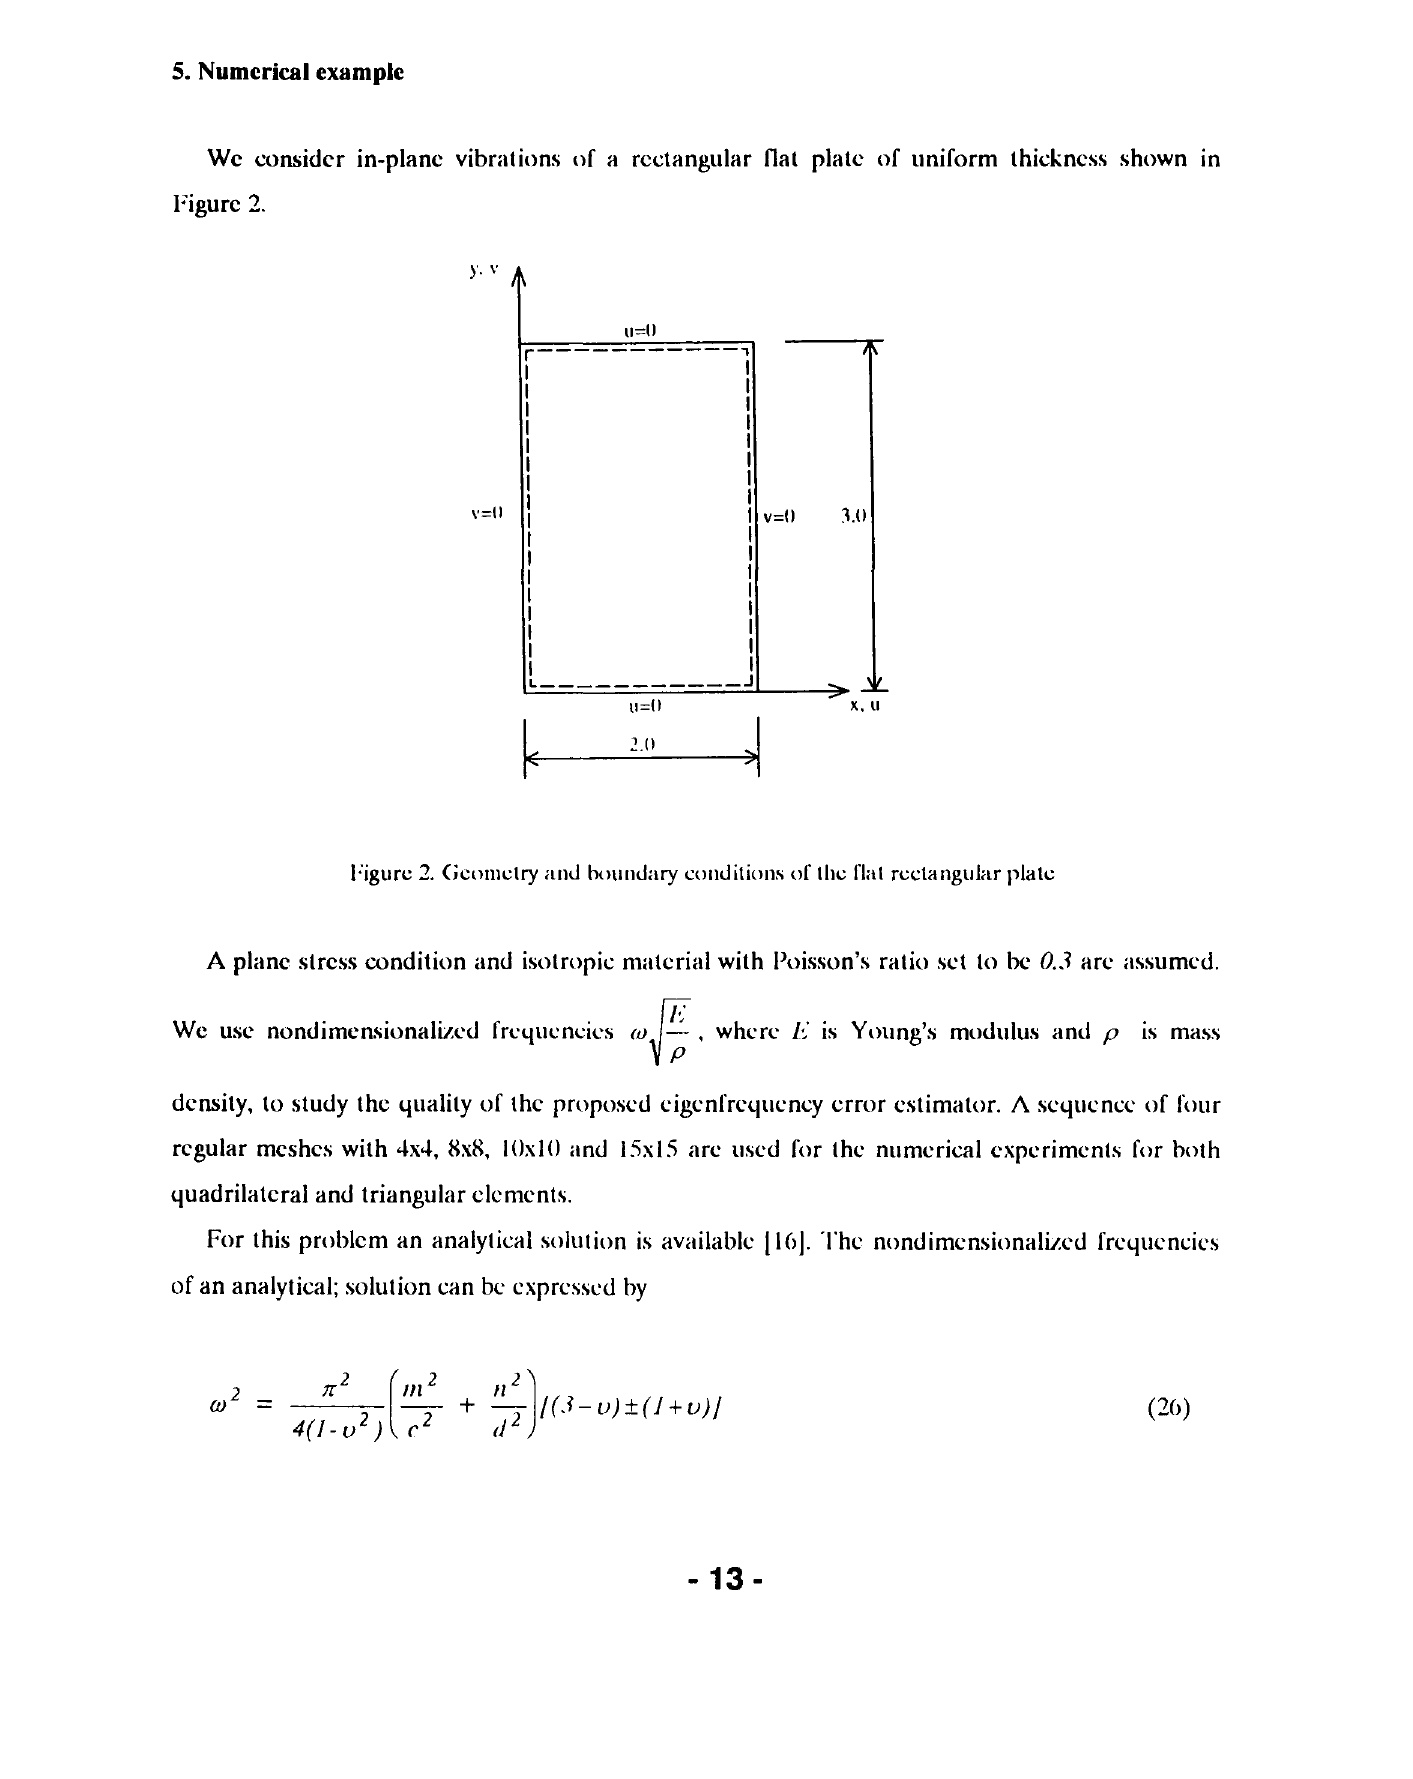
Figure 2. Geometry anJ hounJary conJitions of the flat rectangular